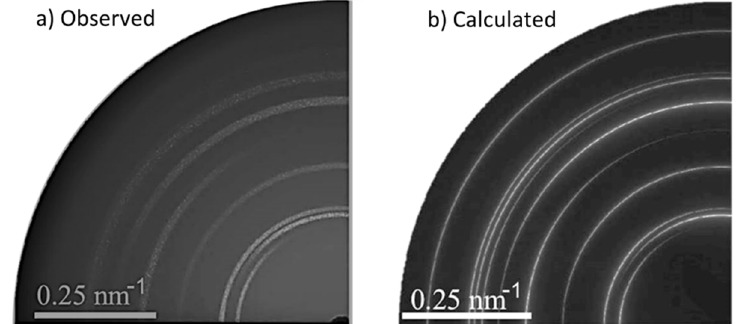
Figure 9. 2D-GIXRD patterns of ZnO nanorods: ( a ) as observed at SSRL beamline 11.3 MAR345 detector; and ( b ) showing the texture simulation with program ANAELU [54]. Reproduced with permission from [53].